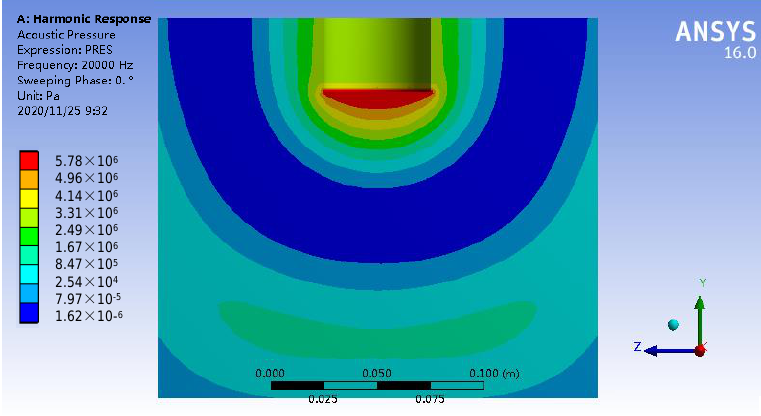
Figure 9. Ultrasonic sound-pressure field distribution.